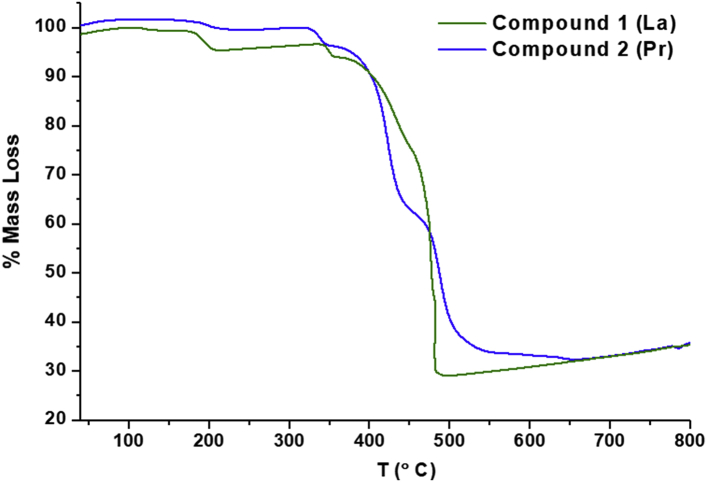
Thermal profile for [Ln(4-OHBBA)3(H2O)2] (Ln = La and Pr) compounds.